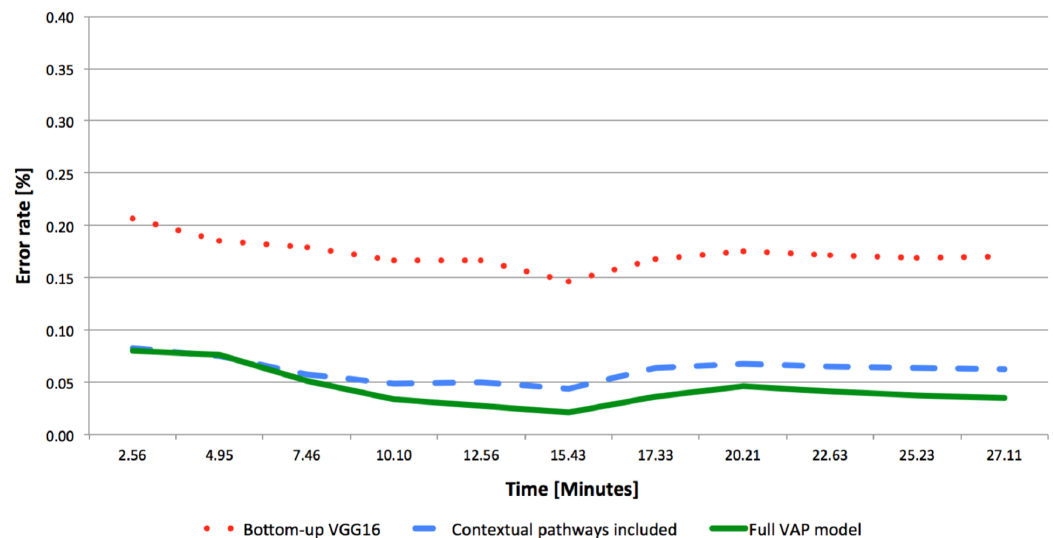
Figure 11. Performance on video sources of the VAP model with the VGG16 faster RCNN as the bottom-up